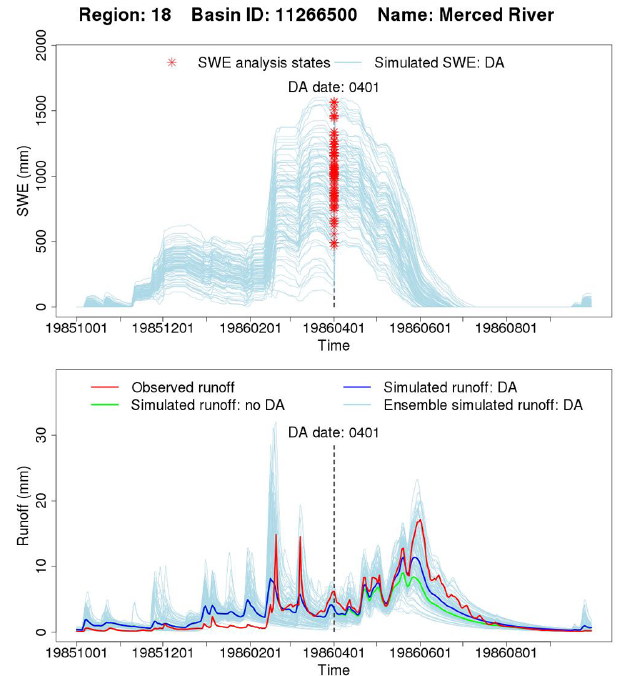
Figure 10. Time series plots for SWE and runoff for the Merced River for water year 1986. Light blue lines indicate individual en- semble member traces. Vertical black dashed line denotes the DA